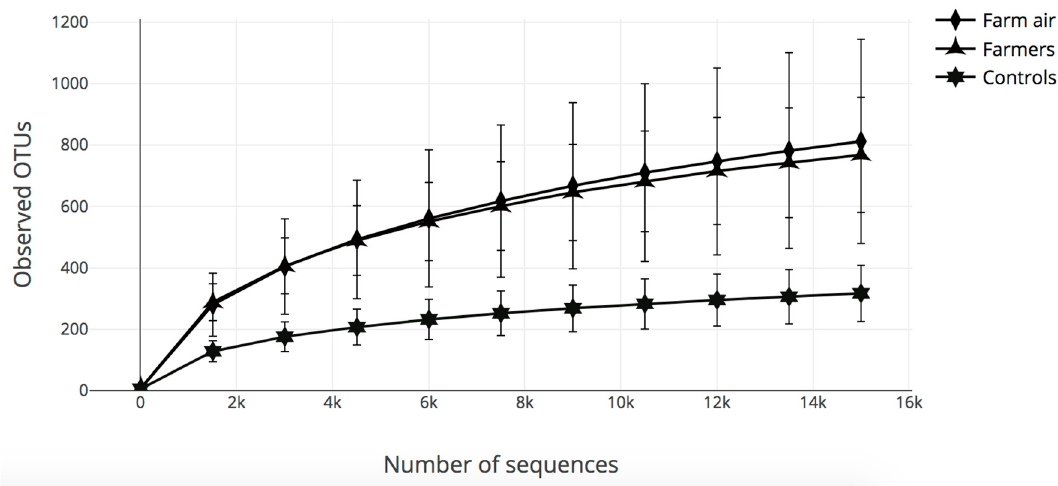
Figure 1. Rarefaction curves obtained from the number of observed operational taxonomic units (OTUs) and the sequences per sample for air samples from pig farms and nasopharynx samples from pig farmers and non-exposed controls. The plateau of the curves started around 2000 sequences.